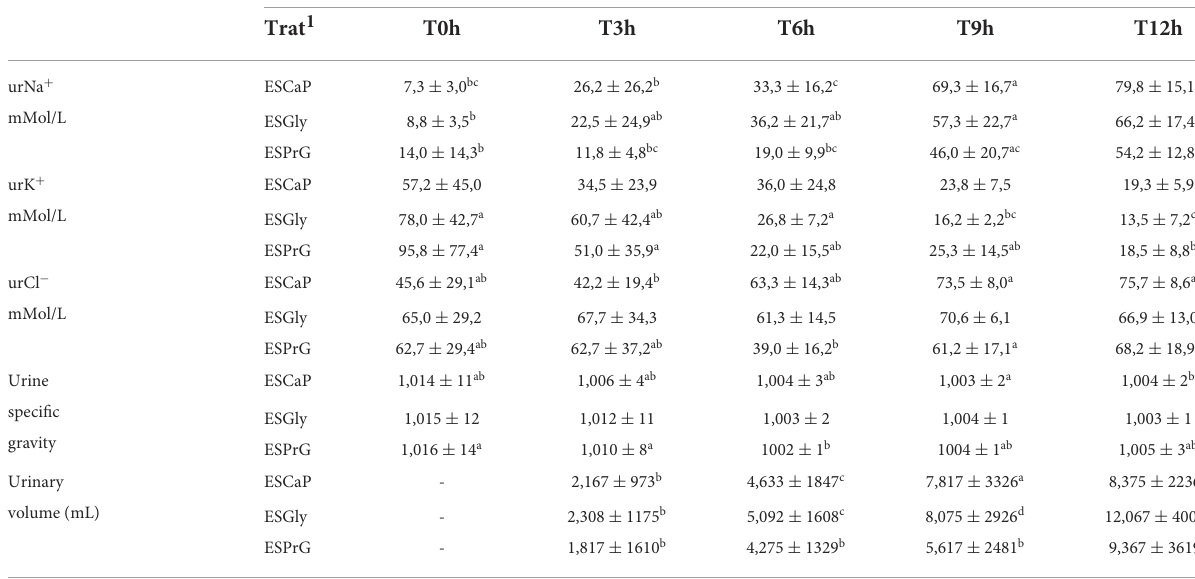
TABLE 3 Mean ± standard deviation of urinary electrolytes (urNa + , urK + , urCl − ), urine specific gravity, and urinary volume in cattle submitted to continuous flow enteral fluid therapy with three electrolyte solutions containing different energy precursors. Variable Fluid therapy